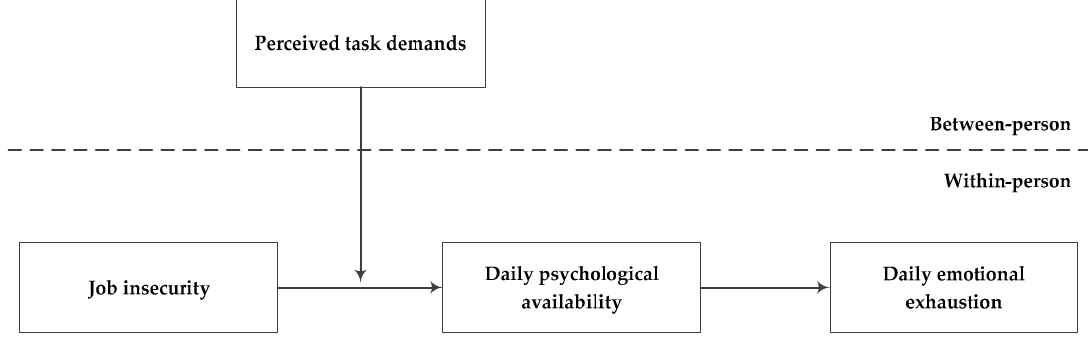
Figure 1. Conceptual model.